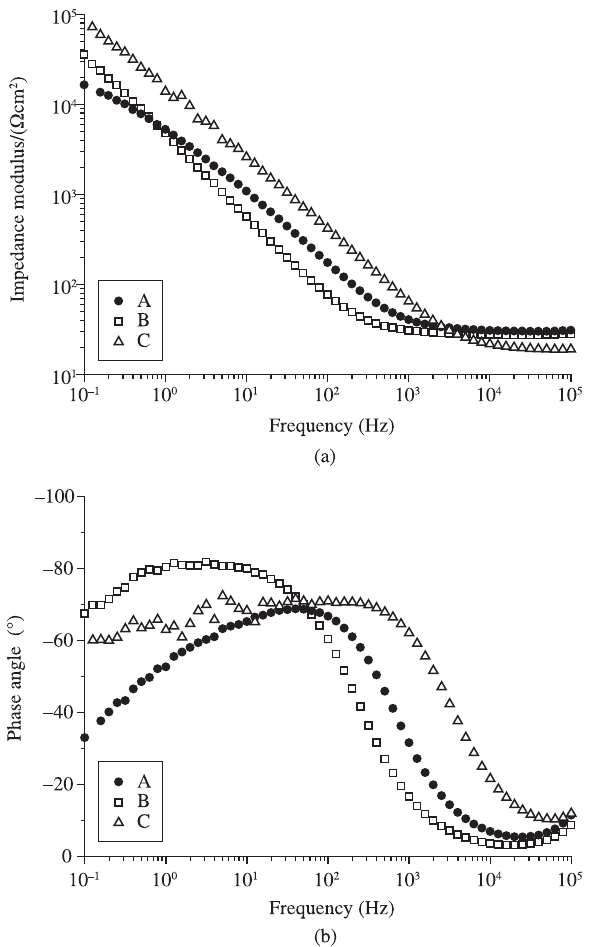
Figure 4. Bode diagrams of the three Ti implants obtained at OCP in arti- ficial saliva: (a) impedance modulus vs frequency and (b) phase angle vs